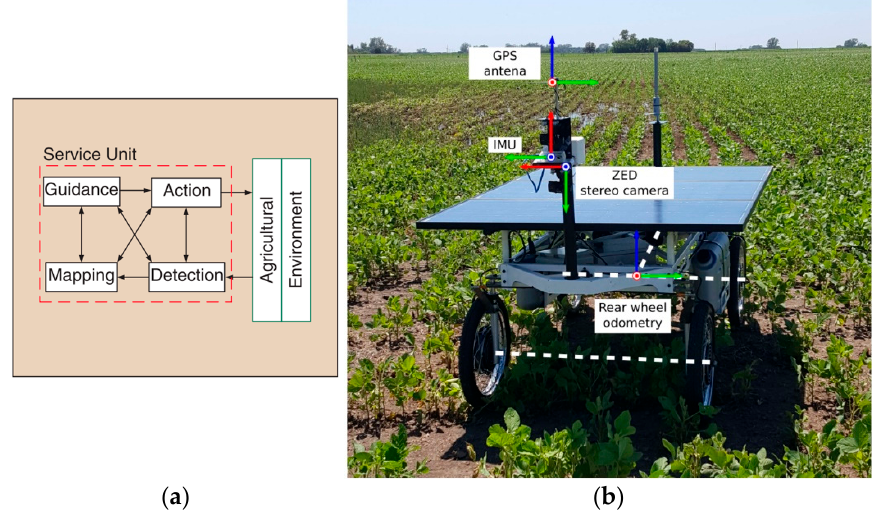
Figure 8. ( a ) Relation between the four most important implementations of an agricultural service unit (an agricultural robot or vehicle) [25]; ( b ) weed removing robot in the soybean field, image extracted from open-source dataset Rosario [26].